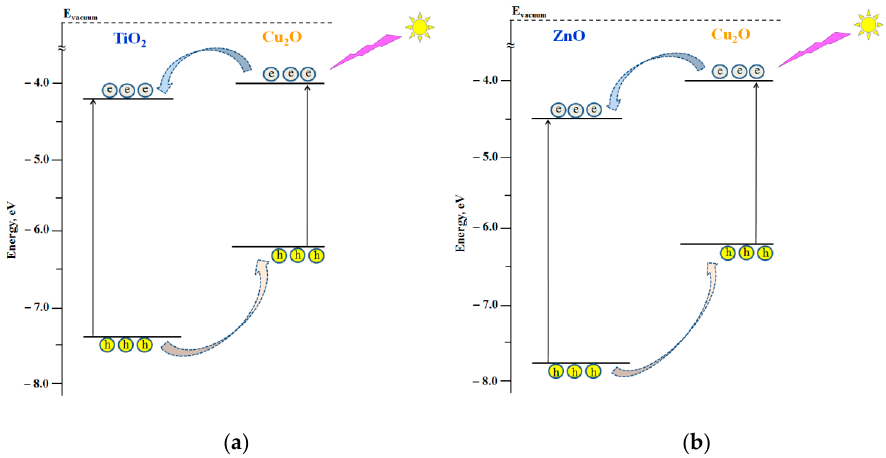
Figure 5. Schemes of the electron transfer in heterostructured coatings under UV light photoexcitation: ( a ) Cu 2 O/TiO 2 and ( b ) Cu 2 O/ZnO.